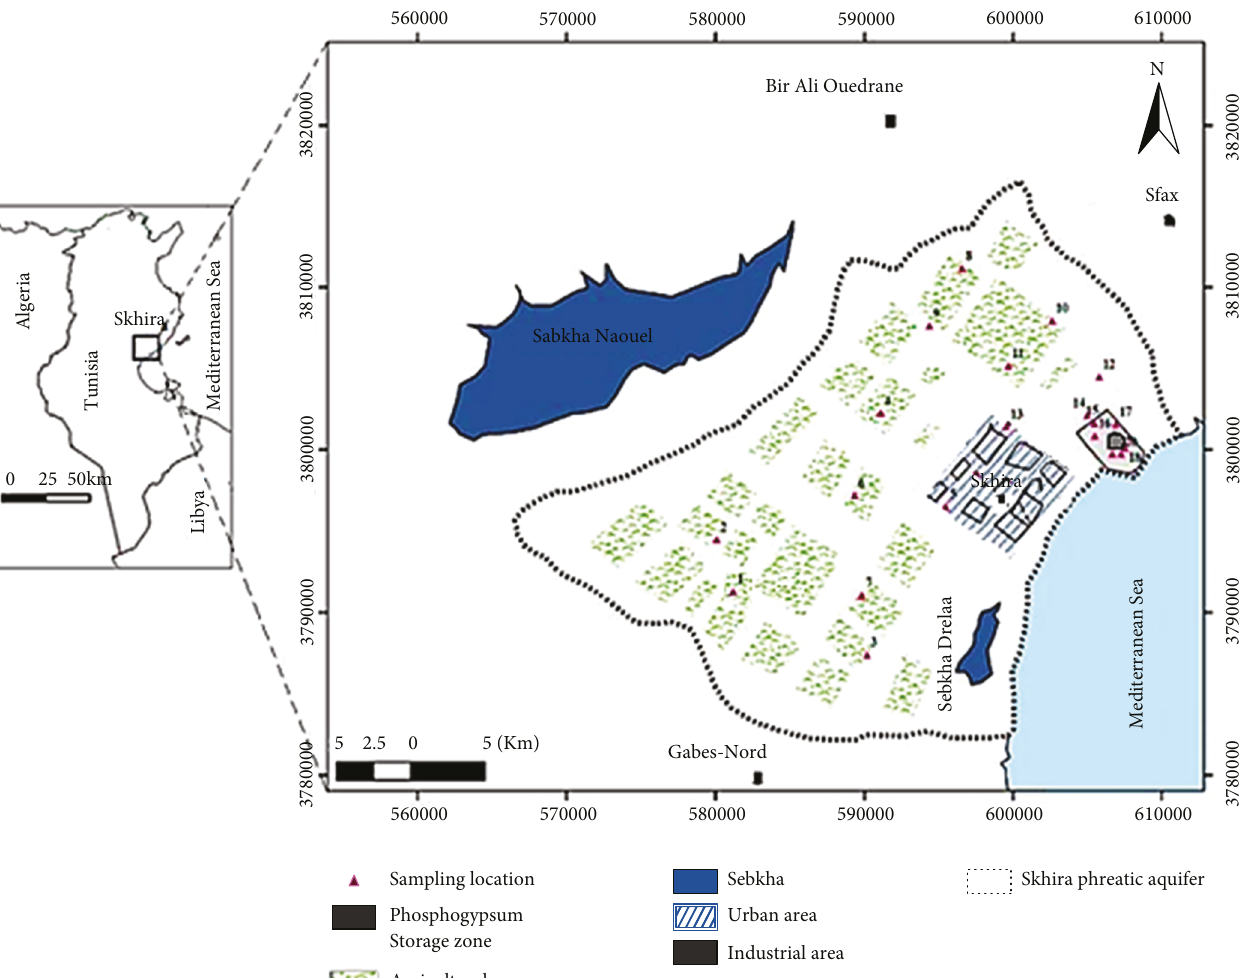
Figure 1: Location map of the study area showing location sampled for groundwater